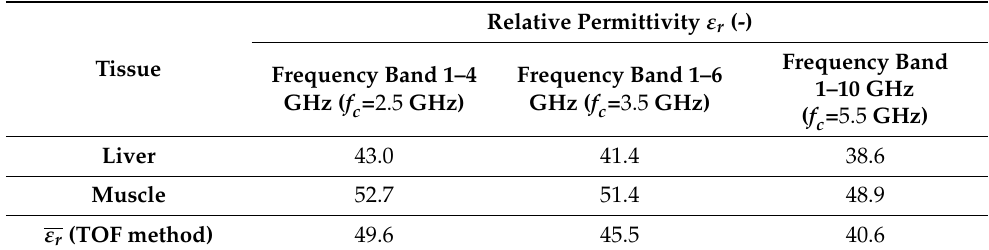
Table 6. Comparison of the average relative permittivity determined by the radar with the relative permittivity of significant tissues in the imaged